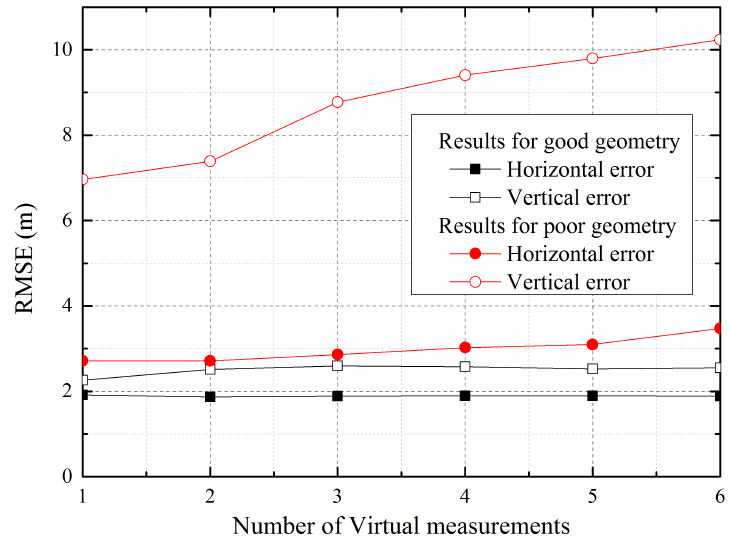
Figure 6. User accuracy according to the number of virtual measurements.